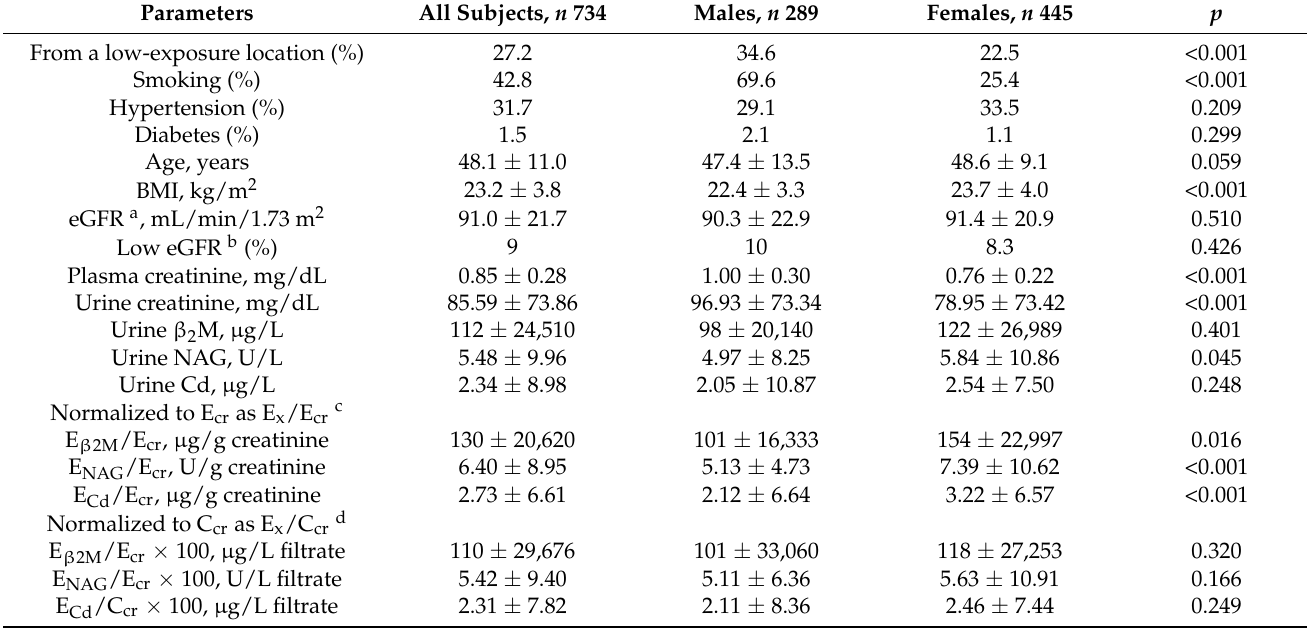
Table 1. Characteristics of the study subjects, stratified by